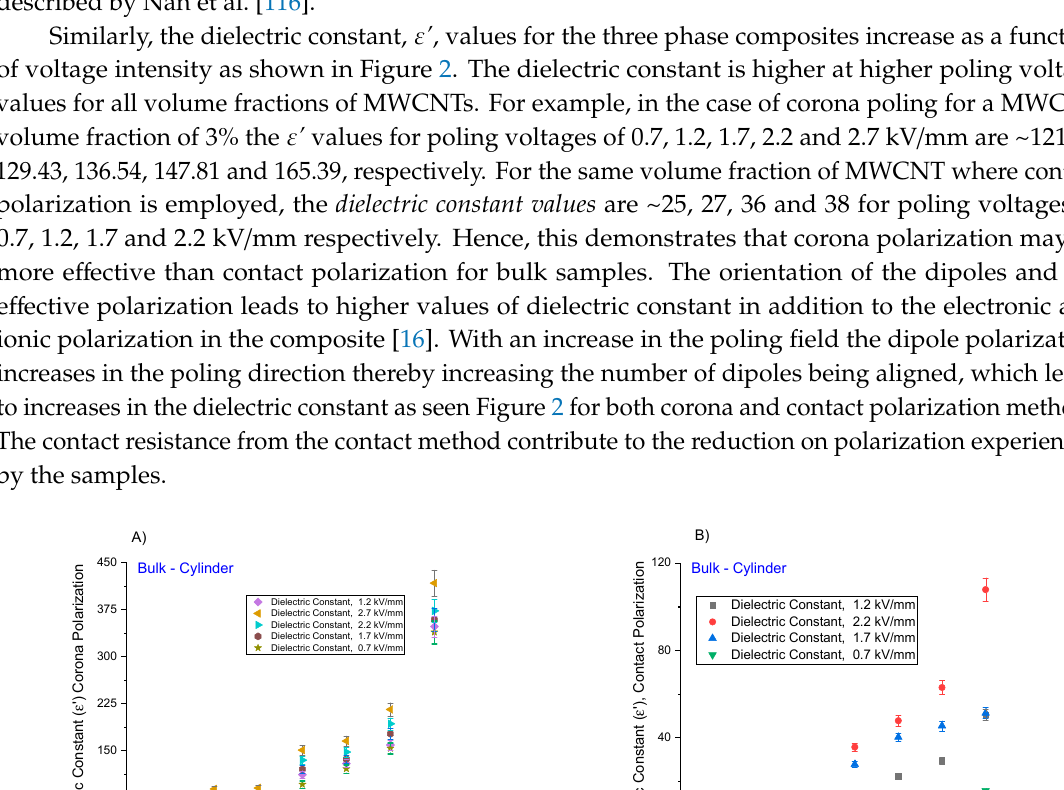
Figure 3. Variation in the dielectric loss, tan δ , as a function of polarization voltage and volume fraction of MWCNT for ( A ) corona and ( B ) contact polarized samples.